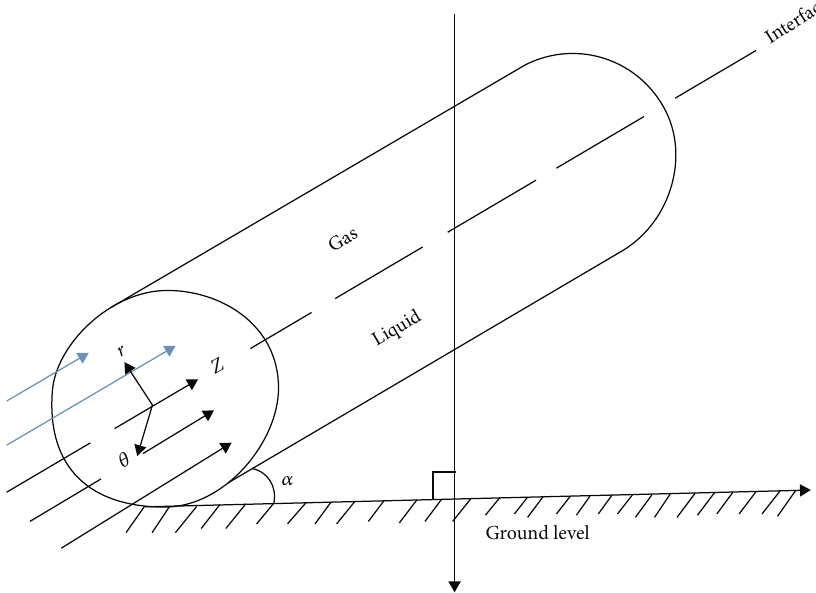
Figure 1: Flow Con fi guration for turbulent two-phase fl ow inclined at an